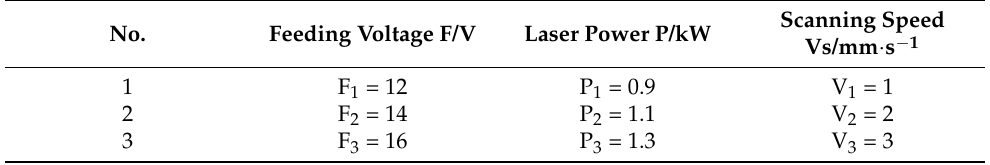
Table 3. Orthogonal experimental design of process parameters.